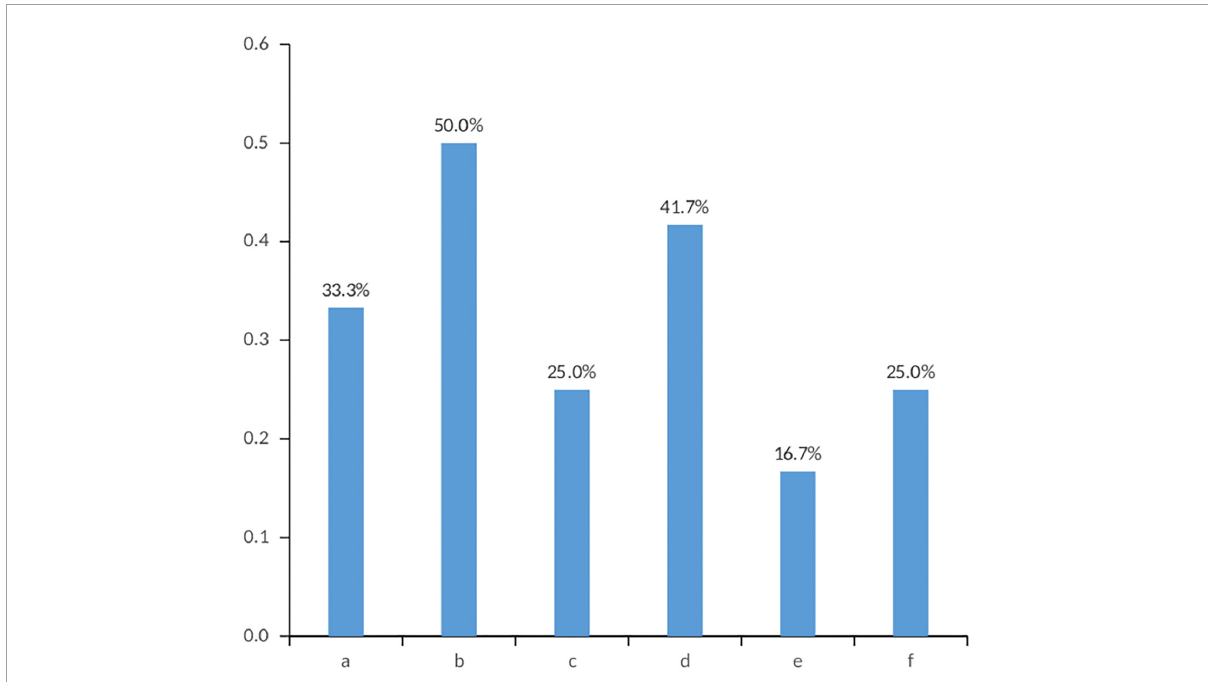
FIGURE2 Reasons why family members regret agreeing to donate organs. a. People’s words; b. Lack of understanding by others; c. Opposition from other family members; d. Shame on the donor. e. The initial decision to donate was not well thought out; f. The community’s help after the donation did not meet